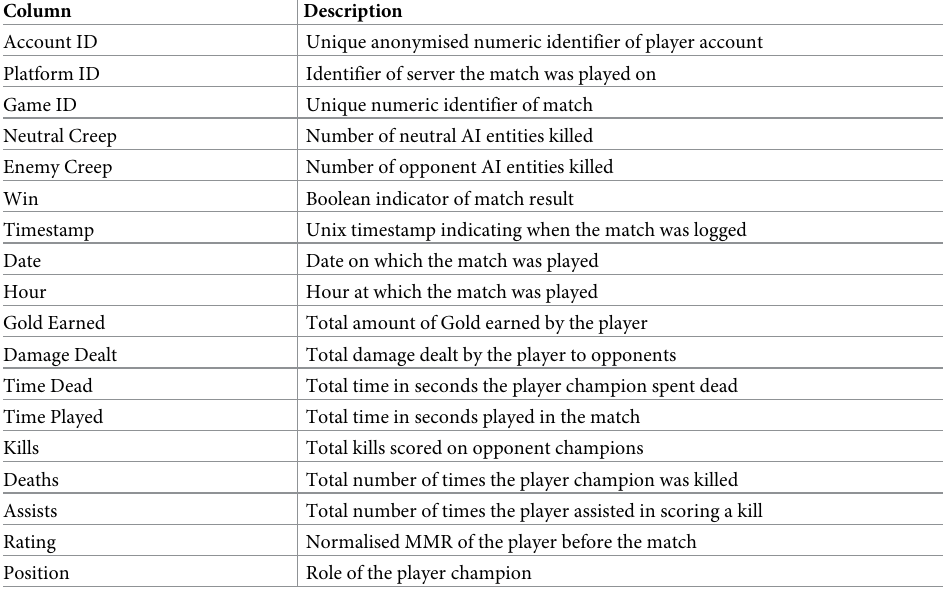
Table 1. Raw data columns available in a single row of the data set analysed in this study. Column